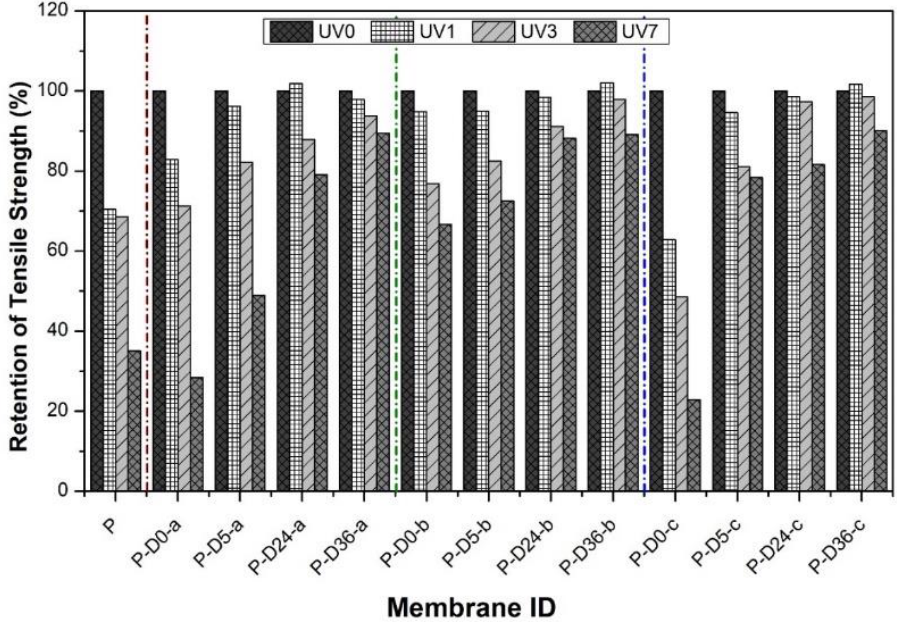
Figure 10. Retention of tensile strength of membranes before and after UV exposure.